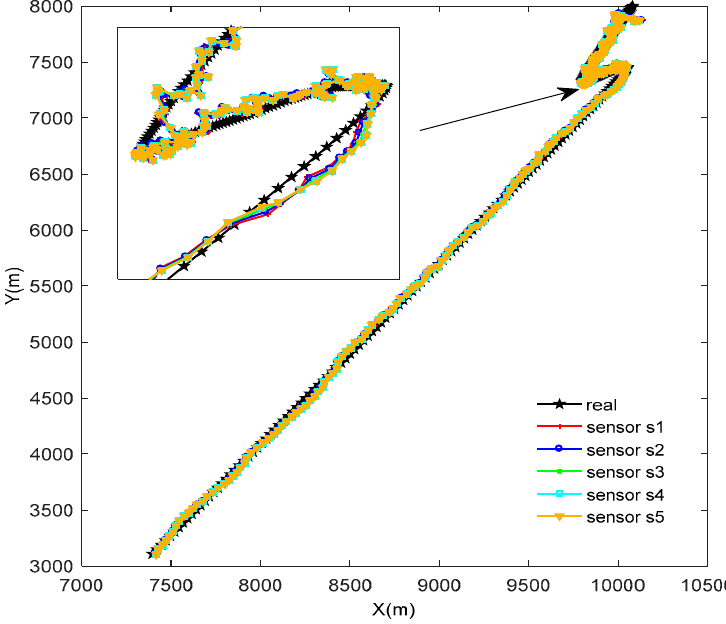
Figure 3. Real and estimated target trajectory.